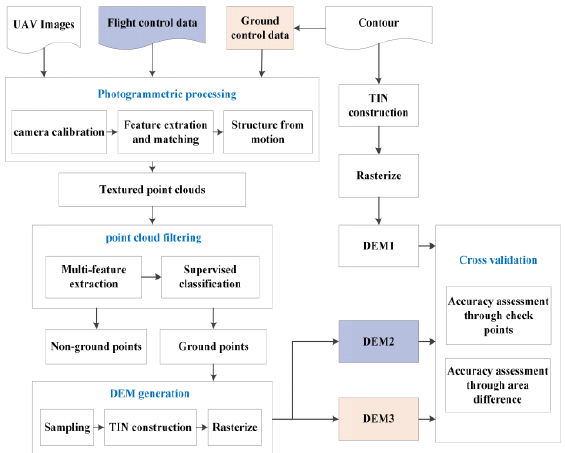
Figure 1.Framework of the proposed